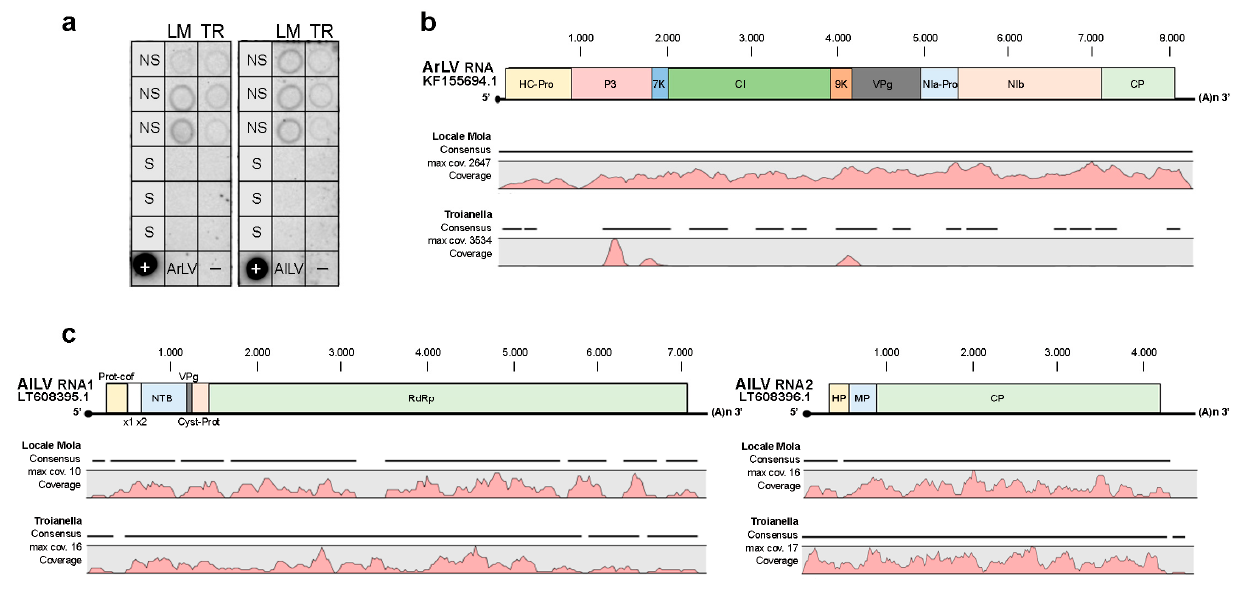
Figure 2. Virus detection in three biological replicates of non-sanitized (NS) and sanitized (S) plants of Locale di Mola (LM) and Troianella (TR) ecotypes. ( a ) Dot blot hybridization analysis using a specific digoxigenin-labeled DNA probe artichoke latent virus (ArLV) and artichoke Italian latent virus (AILV). Leaf extract of the healthy plant ( − ) and 1 ng of unlabeled target sequence (+) were used as controls. Hybridization signals were displayed using the Quantity One software (Bio-Rad Laboratories). Alignment and coverage analysis of RNA sequencing data obtained from LM and TR libraries of NS ecotypes against ( b ) ArLV RNA genome and ( c ) AILV RNA1 and RNA2 sequences. One of the three biological replicates for LM-NS and TR-NS was used to show read position alignment and coverage track results (pink color peaks) on virus genomes using the Integrative Genomics Viewer (IGV) tool.